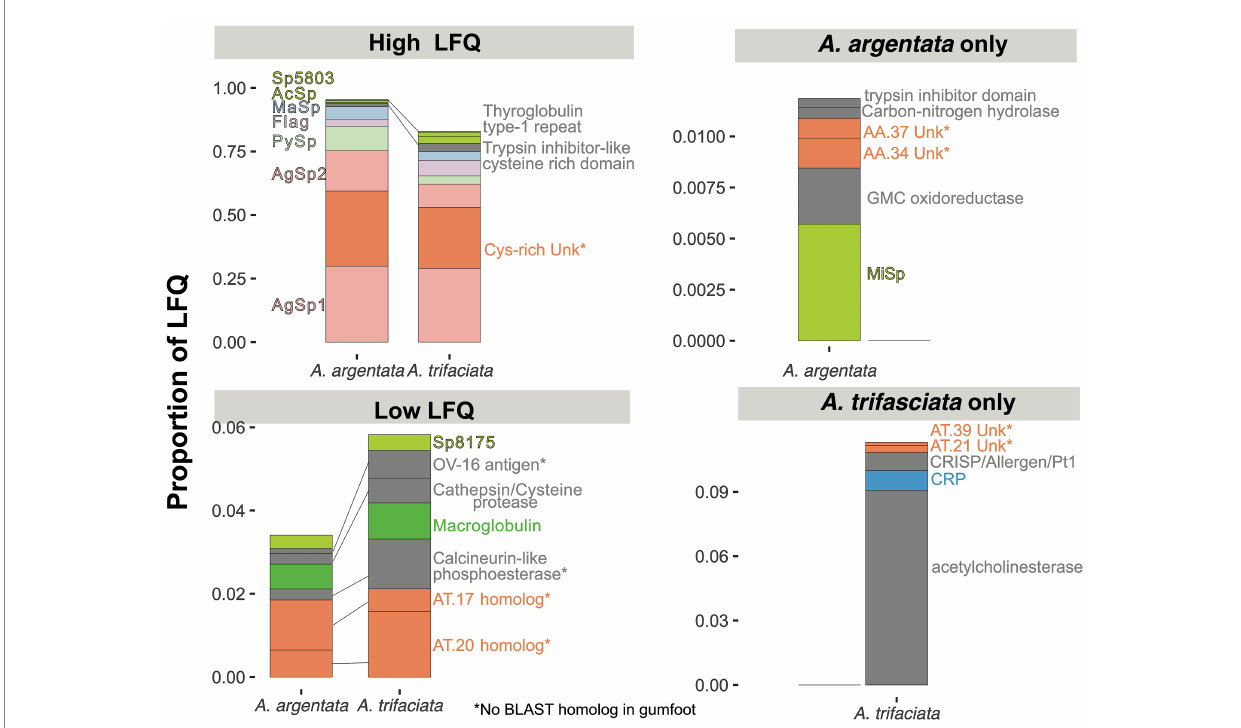
FIGURE 7 Relative abundance of proteins found in the capture spirals of two Argiope species. Colors for spidroins, proteins with no BLAST alignment (e-value < e-05) to a UniProt or PFAM protein (“Unk,” short for unknown), CRP, and macroglobulins are coded as in Figure 6. Proteins with other functions are in grey. Species abbreviation and numeric identifiers match Figure 6. Some homologous groups shown here include multiple proteins (e.g., 11 Cys-rich Unk in A. argentata and 7 in A. trifasciata , see Supplementary Tables S1, S2). Asterisk (*) indicates that we did not find a significant BLAST alignment between the Argiope protein(s) and a gumfoot protein in L. hesperus or P. tepidariorum (Figure